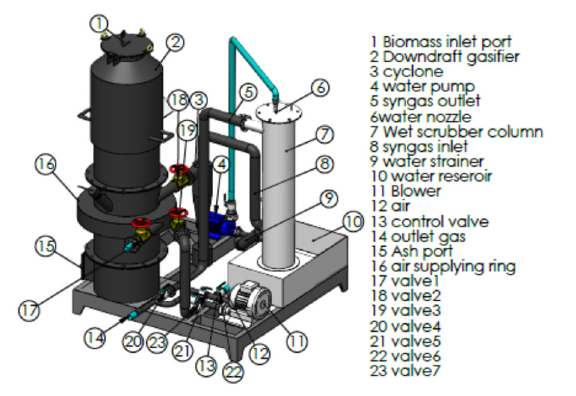
Fig. 1: Downdraft gasifier